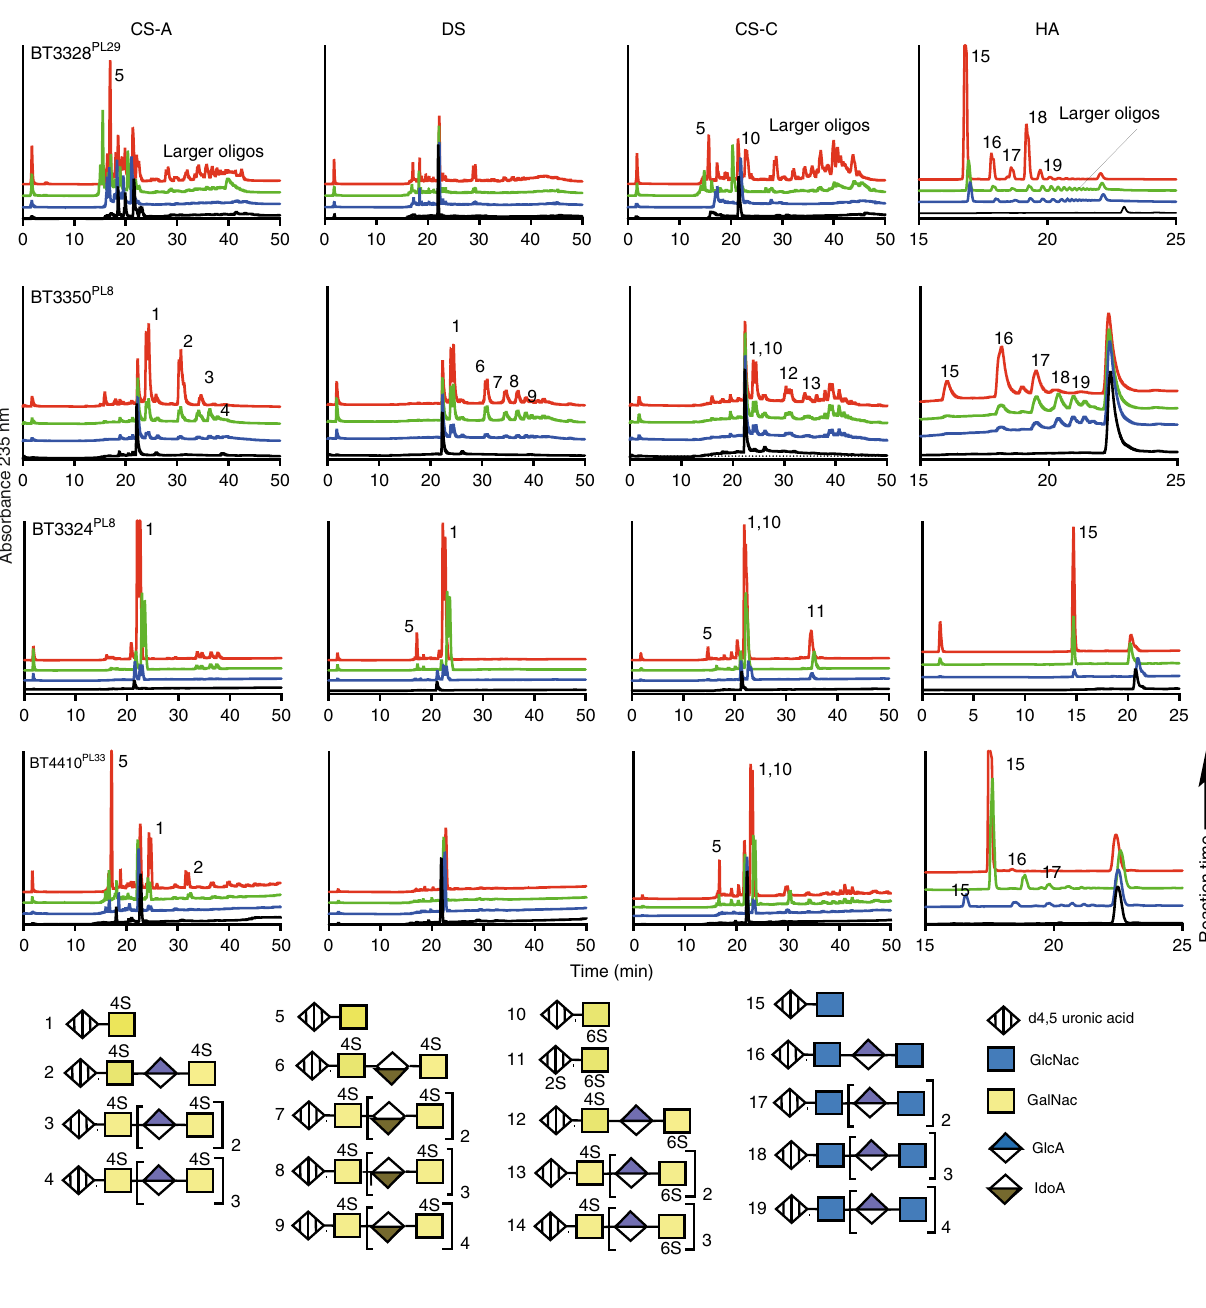
Fig. 2 HPLC product pro fi les of the PUL CS/DS/HA encoded lyases. Peaks were identi fi ed by comparison with commercially purchased standards. The black, blue, green and red lines represent 0, early, mid-point and late stages of the reaction time course for each enzyme (CS-A chondroitin sulfate A, DS dermatan sulfate, CS-C chondroitin sulfate C and HA hyaluronic acid). All reactions were carried out in 50 mM MES, pH 6.5, with 150 mM NaCl at 37